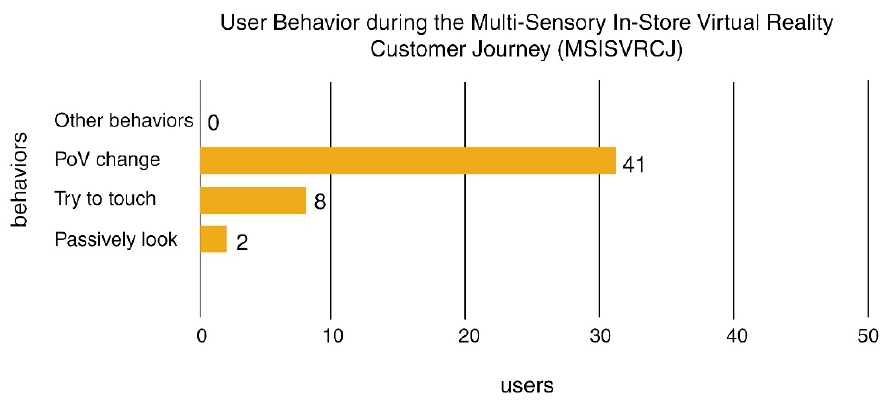
Figure 6. User behavior during the Multi-Sensory In-Store Virtual Reality Customer Journey.